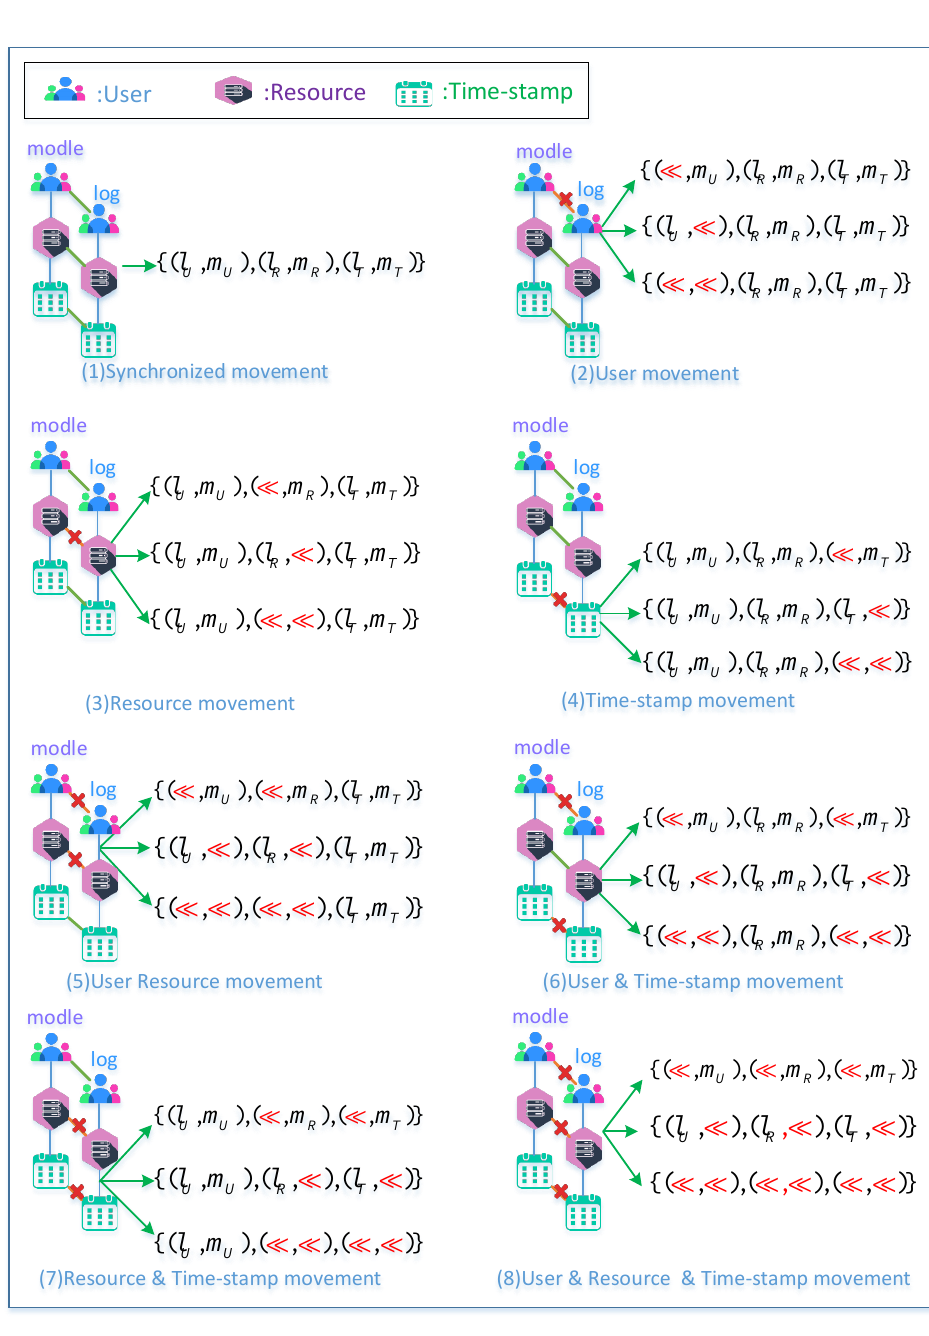
Figure 6. Possible movement when logs are aligned with models for properties.